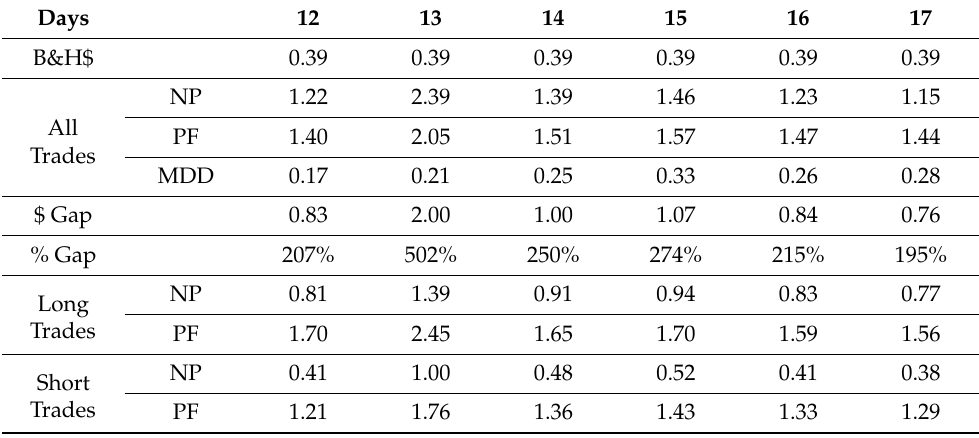
Table 3. Results for XRP trades.